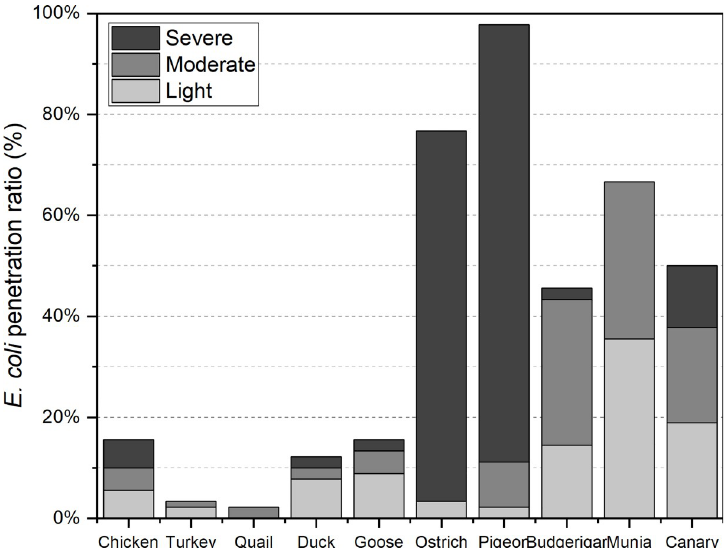
Fig 6. E coli contamination grades for the ten species. Light (light gray), moderate (gray), and severe (dark gray) contamination represent 1 to 3, 4 to 10, and more than 10 E . coli luminescence spots on the inner surface of one eggshell, respectively.